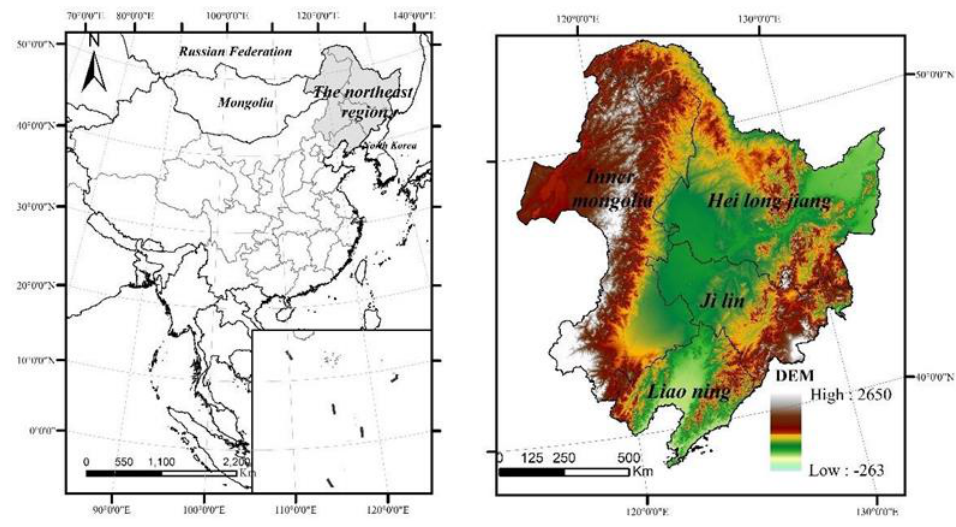
Figure 1. Map of the study area.